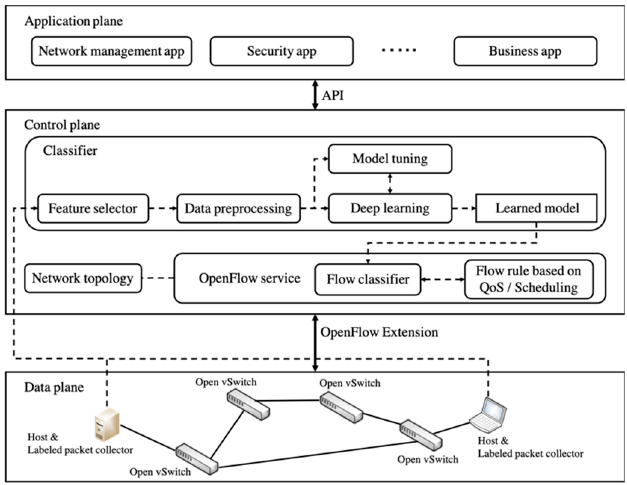
Figure 1. Proposed architecture in software defined network (SDN)-based Network.